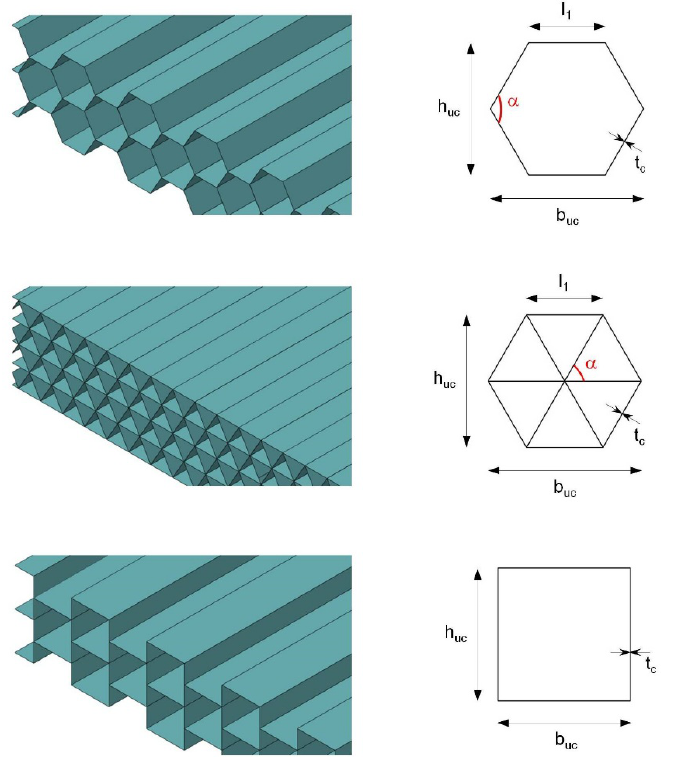
Figure 5. Sections of non-auxetic prismatic and one-side-open core structures with their associated unit cells (two-layer, 2L). From top to bottom: honeycomb, isogrid, and quadratic core.